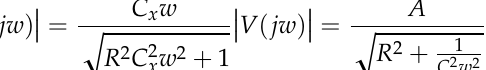
Figure 8. The model of piezoelectric stack actuators.